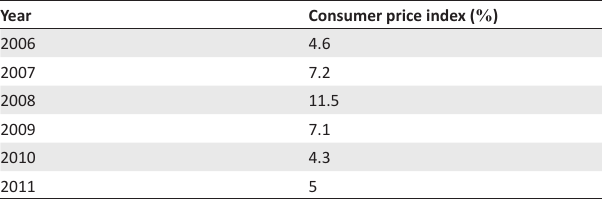
TABLE 6: Consumer price index.